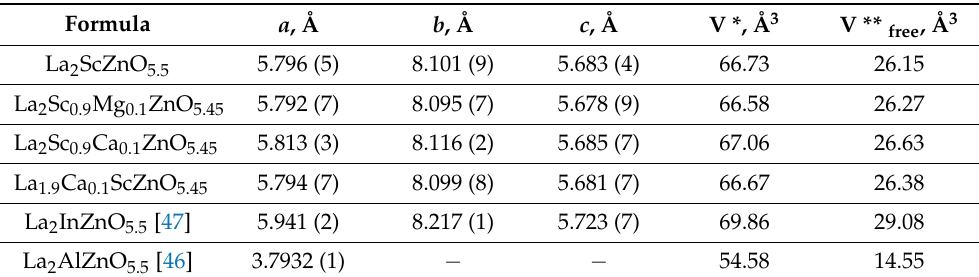
Table 1. The lattice parameters for La 2 ScZnO 5.5 and doped phases in comparison with the literature data for La 2 InZnO 5.5 [47] and La 2 AlZnO 5.5 [46].